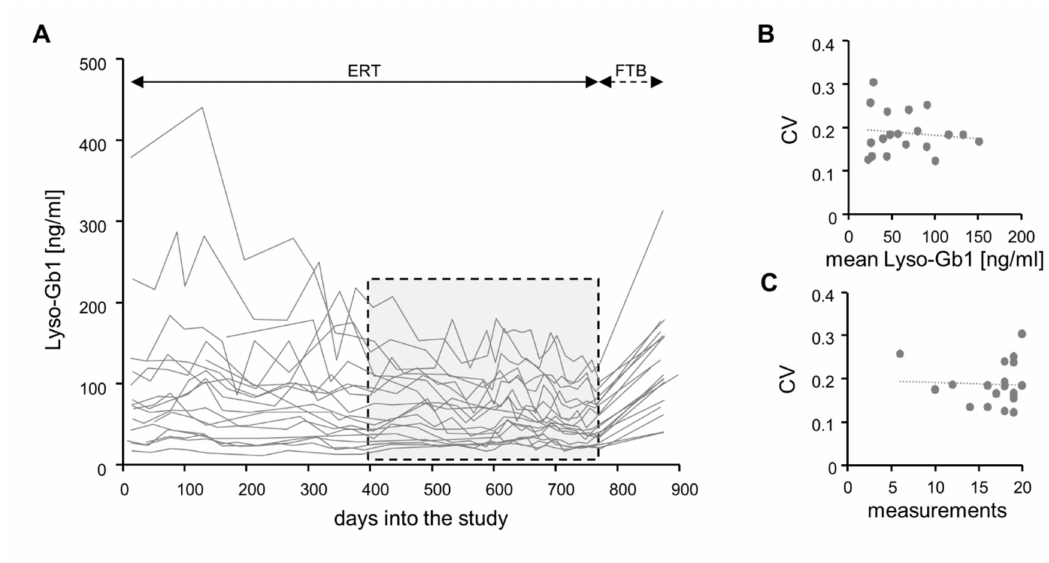
Figure 1. Lyso-Gb1 values in a cohort of 19 routinely monitored Gaucher patients. ( A ) A total of 517 measurements are depicted as one line per patient. The stippled box denotes the subset of 317 measurements over a ~12-month period on which the diagrams in Figure 1B,C, and Figure 2 are based (compare also text). ( B ) Patient-specific coe ffi cients of variation are plotted against patient-specific mean Lyso-Gb1 values. ( C ) Patient-specific coe ffi cients of variation are plotted against the number of measurements available per patient. CV, coe ffi cient of variation; ERT, enzyme replacement therapy; FTB, forced treatment break; trendlines were set to